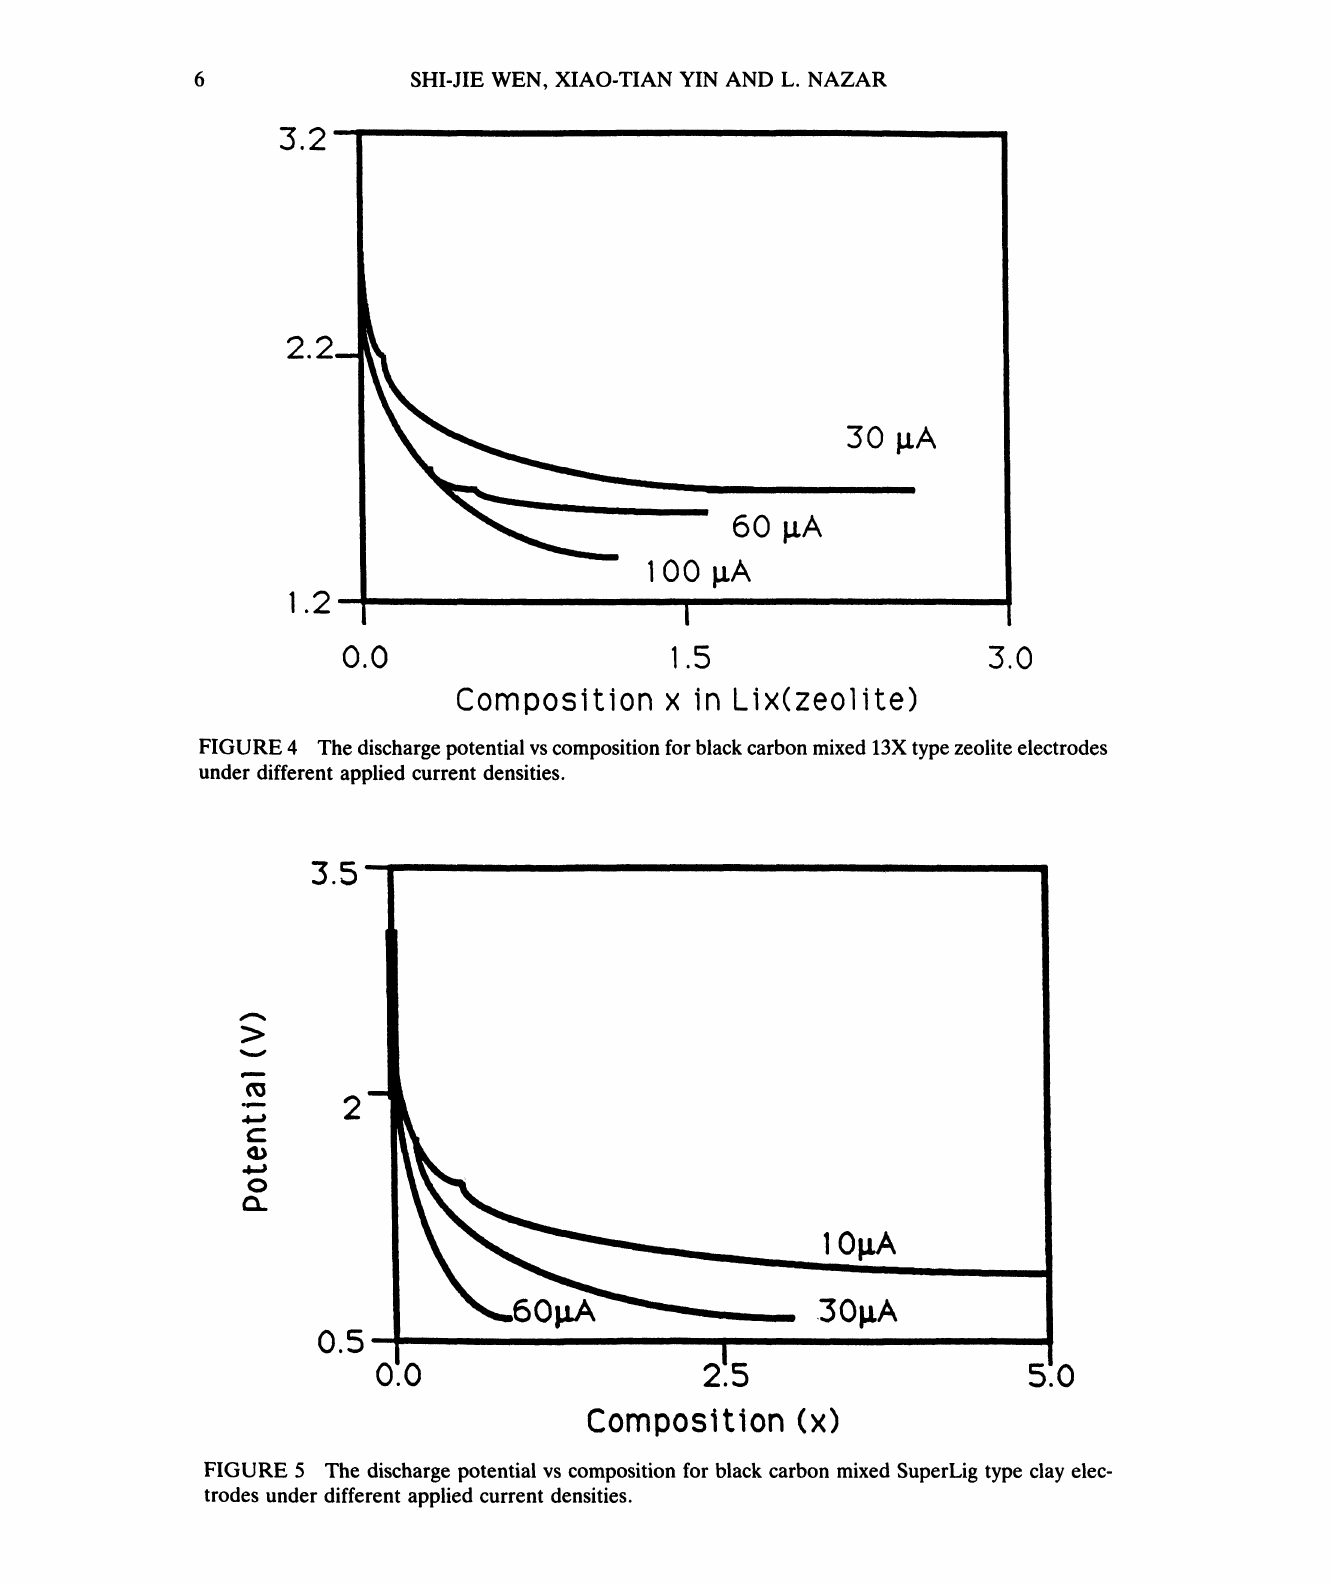
FIGURE 5 The discharge potential vs composition for black carbon mixed SuperLig type clay elec- trodes under different applied current